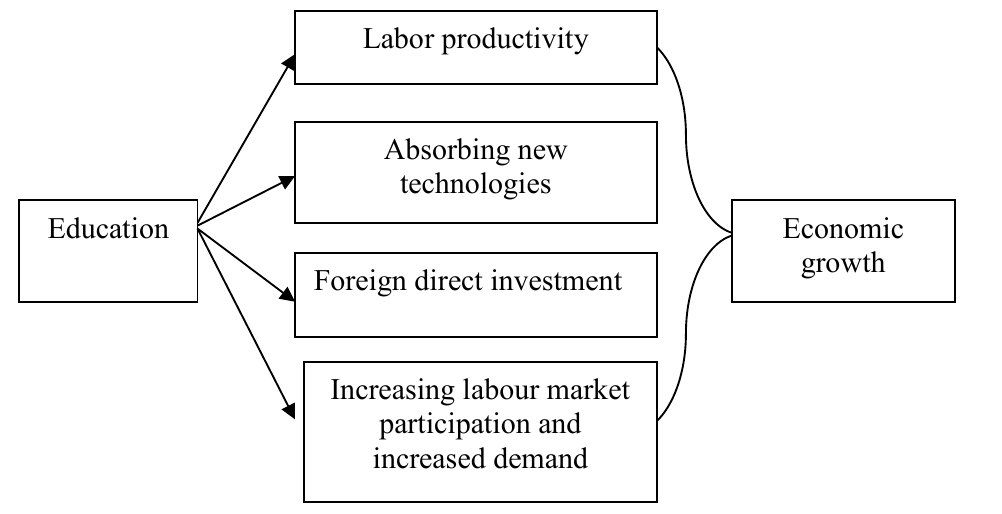
Fig. 1. The channels through which education affects economic growth (Pribac & Anghelina,